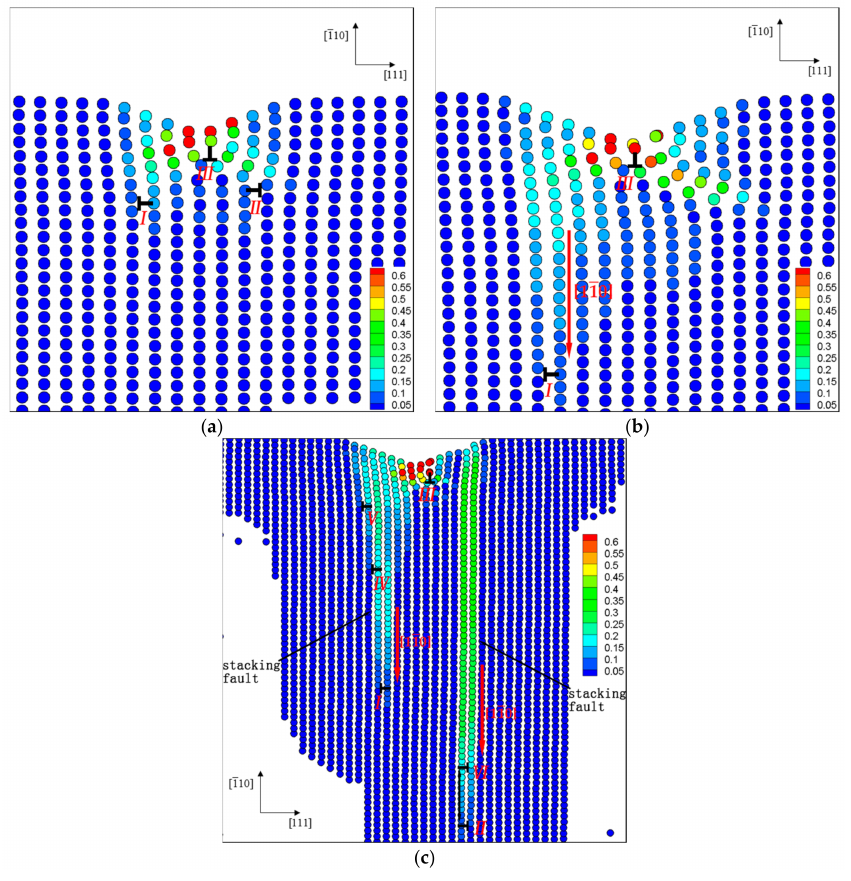
Figure 7. Strain distribution and dislocations beneath the wedged indenter with half vertex angle of